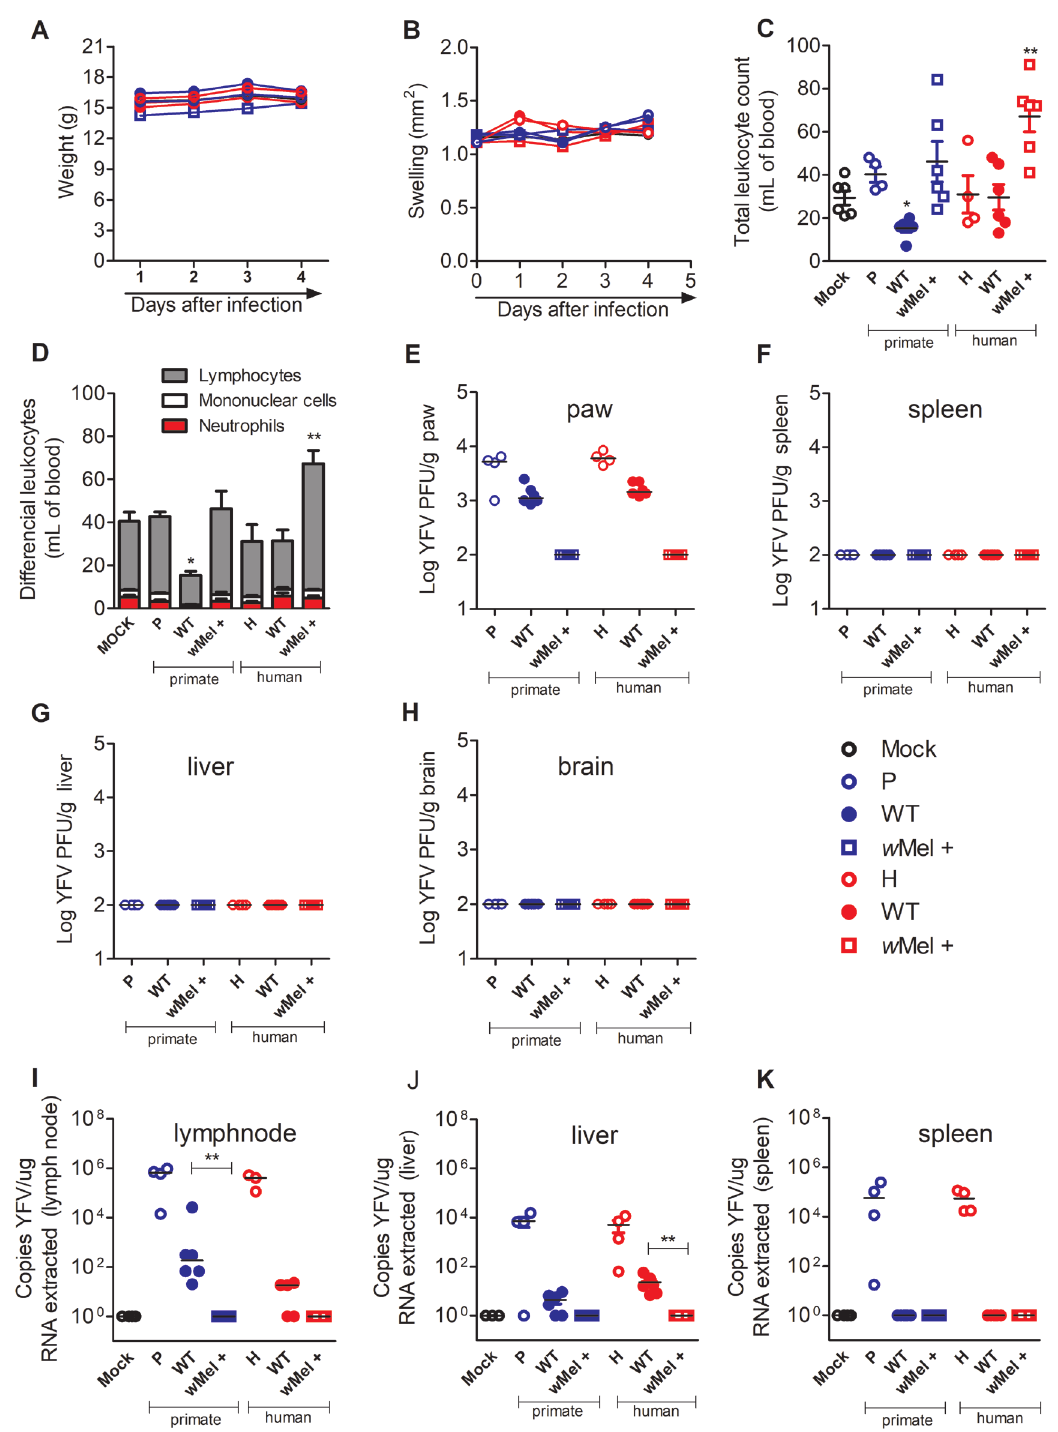
Figure 5. Saliva from Wolbachia -positive mosquitoes lose its capacity to transmit yellow fever virus in vivo . A129 -/- mice were inoculated with 1 × 10 4 PFU of YFV primate (empty blue circles) and human YFV (empty red circles) or with a pool of saliva from wild tipe (WT) YFV primate (full blue circles), WT YFV human (full red circles), Wolbachia -positive ( w Mel +) YFV primate (empty blue squares) and Wolbachia -positive YFV human (empty red squares) previously infected with YFV via intraplantar route (50 μl/paw). Control mice (MOCK group) received 50 μl of PBS solution (empty black circle). ( A ) Body weight analysis shown as body weight (g) of mice. ( B ) Paw volume measured daily and shown as swelling (mm 2 ). On day 4 post-infection mice were euthanized and the following analysis performed. ( C–D ) Total and differential leukocyte counts in the blood. ( E–H ) Viable viral loads recovered from paw ( E ), spleen ( F ), liver ( G ) and brain ( H ) by plaque assay in Vero cells. Results are shown as Log PFU/g of tissue. ( I–K ) Viral RNA copies recovered from popliteal lymph node ( I ), liver ( J ) and spleen ( K ) by RT-qPCR. Data was presented as mean ± SEM or median (n=4 mice for MOCK, n=6 mice for WT P, w Mel + P, WT H and w Mel + H groups and n=4 for YFV P and YFV H, one-way